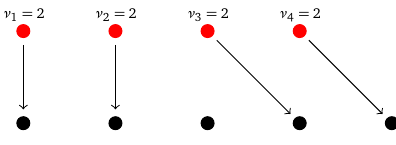
Figure 6: Sketch of the leading configurations contributing to M = N − 1.